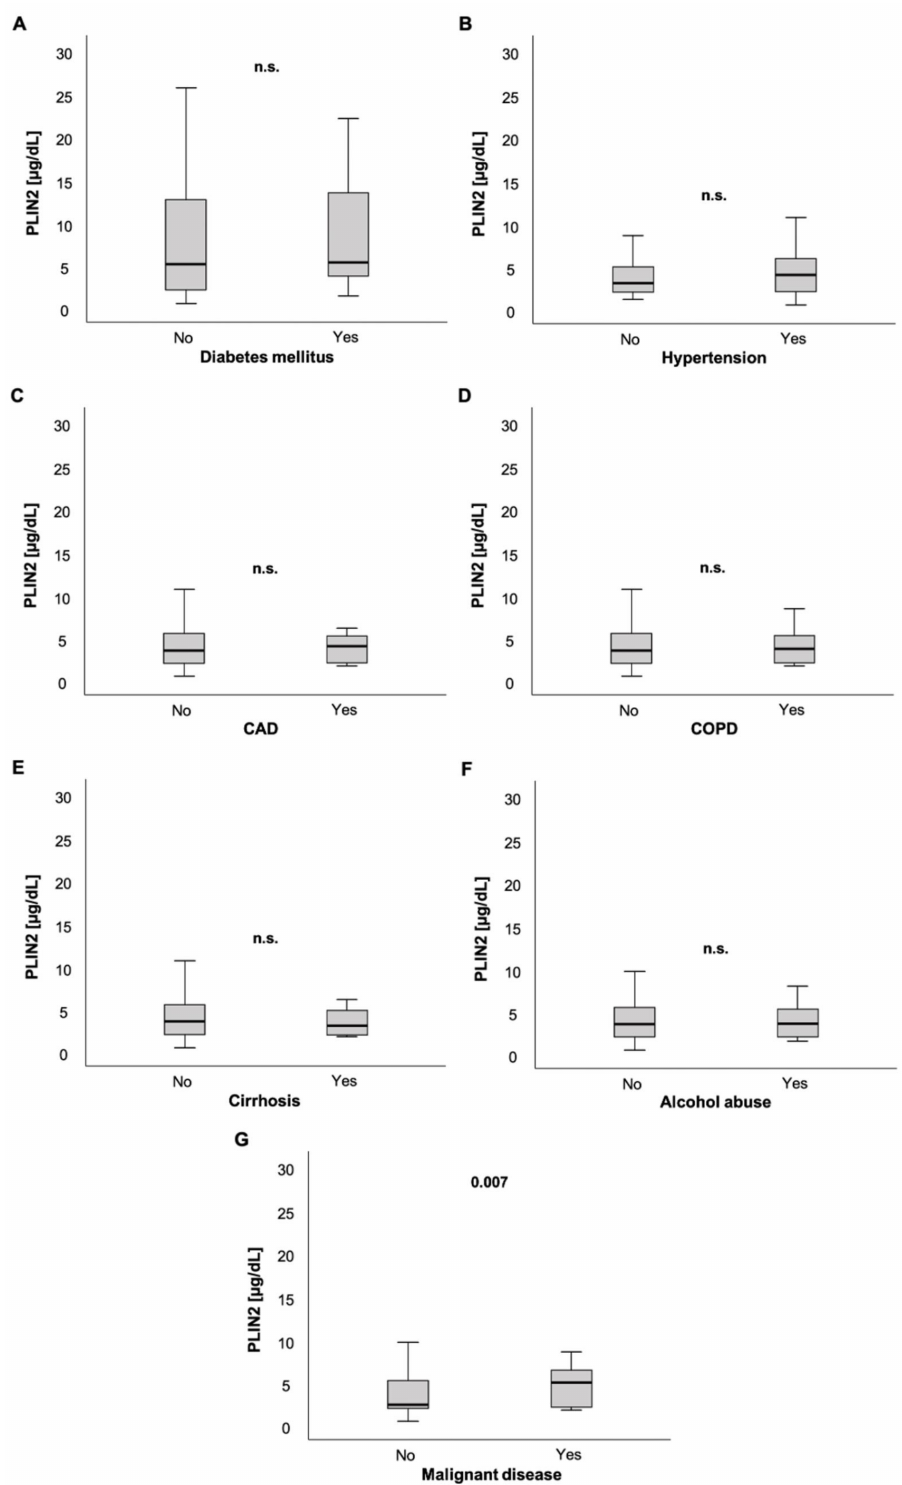
Figure 2. PLIN2 serum levels and preexisting chronic comorbidities. PLIN2 levels were not signifi- cantly different in ICU patients with preexisting diabetes mellitus, arterial hypertension, coronary artery disease, chronic obstructive pulmonary disease, liver cirrhosis and chronic alcohol abuse compared to their counterparts without these comorbidities ( A – F ). ICU patients with pre-diagnosed malignant disease had significantly elevated serum PLIN2 levels ( G